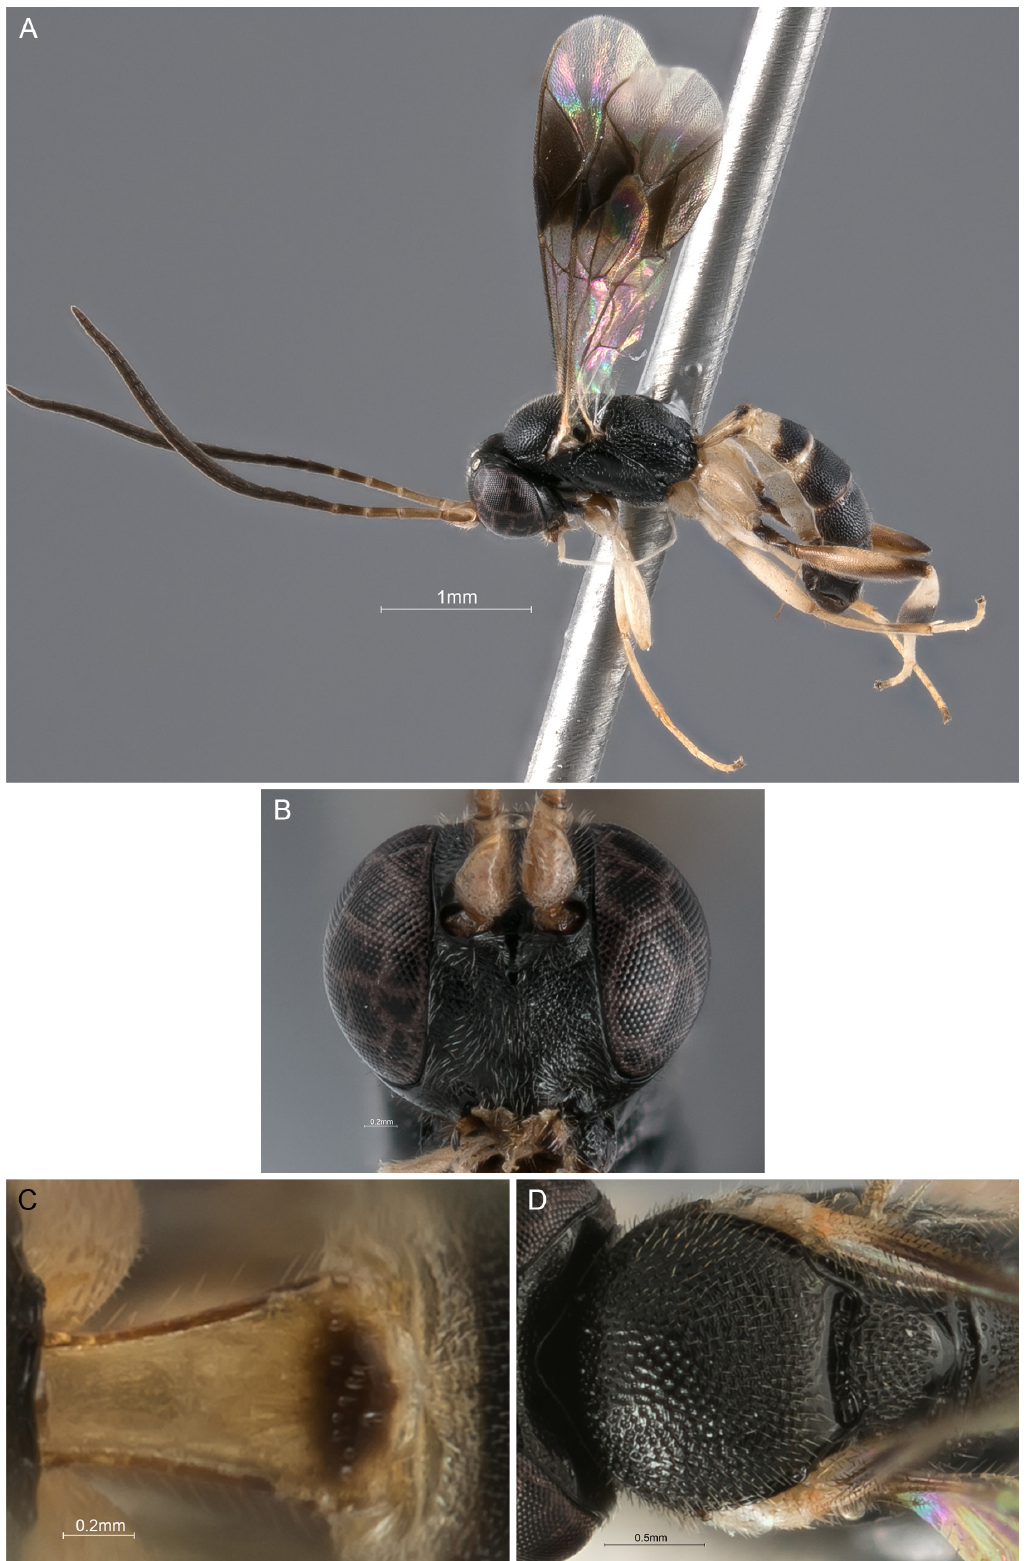
Fig. 11. Palpostilpnus mangrovi sp. nov., holotype, ♀ (LKCNHM). A . Lateral habitus. B . Head, anterior view. C . T1, dorsal view. D .